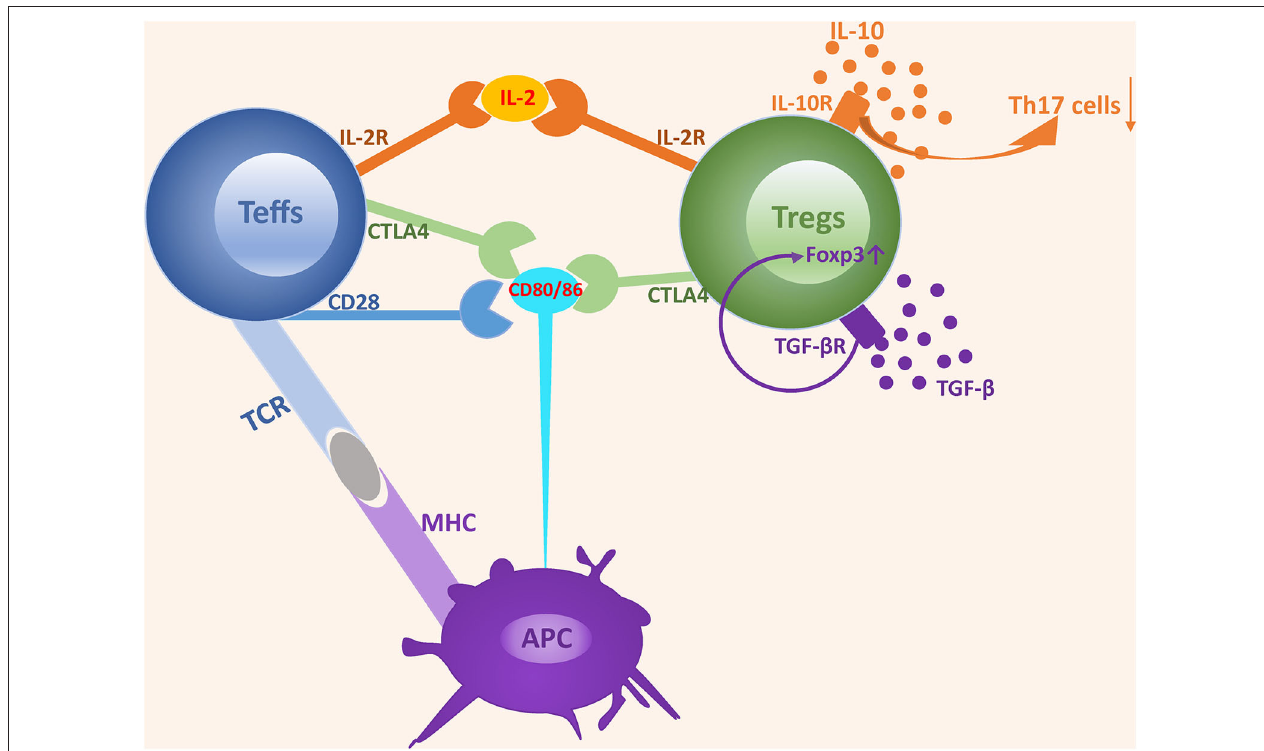
FIGURE 1 | The mechanisms underlying the suppressive function of Tregs. The suppressive function of Tregs is achieved via two mechanisms: cell-contact dependent mechanism and cell-contact independent mechanism. Tregs express a high-affinity IL-2 receptor and can competitively bind to IL-2 with Teffs, which induces IL-2 consumption and suppresses the development and expansion of Teffs. Both CD28 and CTLA4 interact with CD80/CD86 expressed on APCs. However, the affinity of CD28 is lower than that of CTLA4. CD28 plays an important role in enhancing Teffs activation, while CTLA4 acts as an inhibitor by depriving ligands and suppressing CD28 signaling. TGF- β and IL-10 are two classes of nonspecific cytokines secreted by Tregs and can promote Tregs expansion and suppressive activity by binding to their receptors.